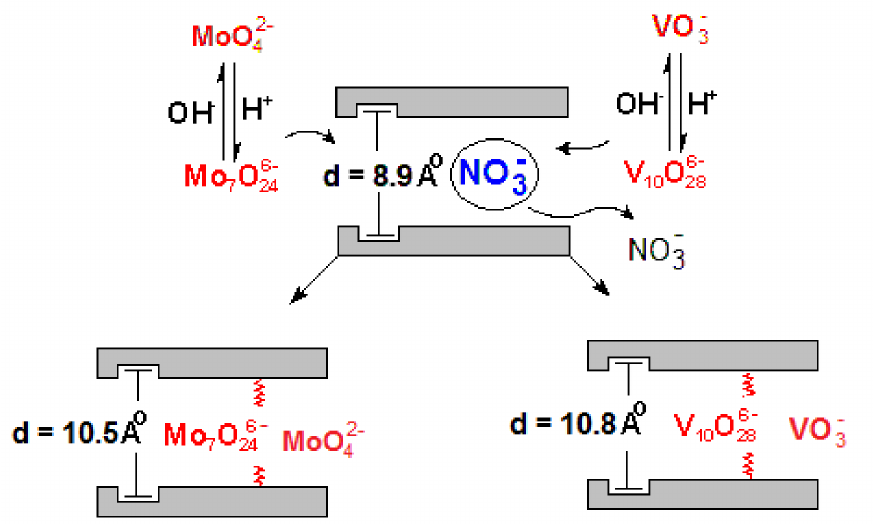
Figure 6. Schematic representation of the intercalation of Mo- and V-oxoanions by anion exchange. Previously unpublished